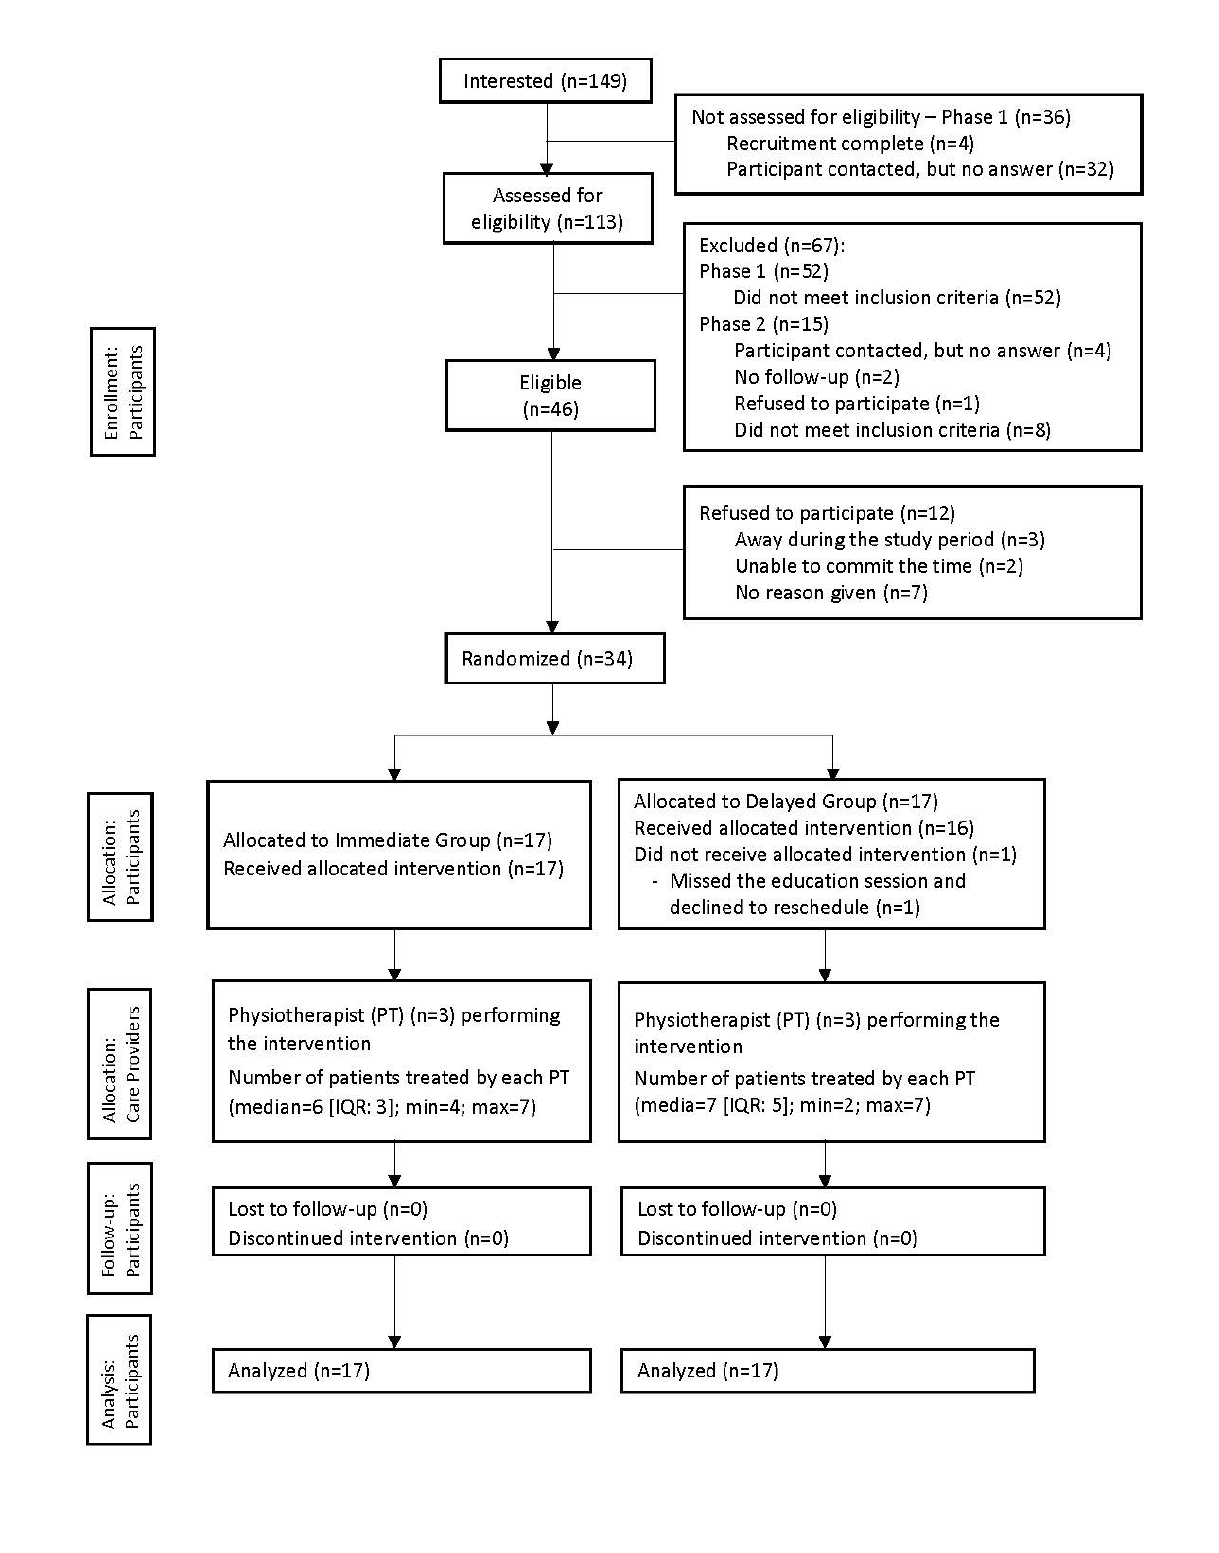
Figure 1. Consolidated Standards of Reporting Trials (CONSORT) flowchart. IQR: interquartile